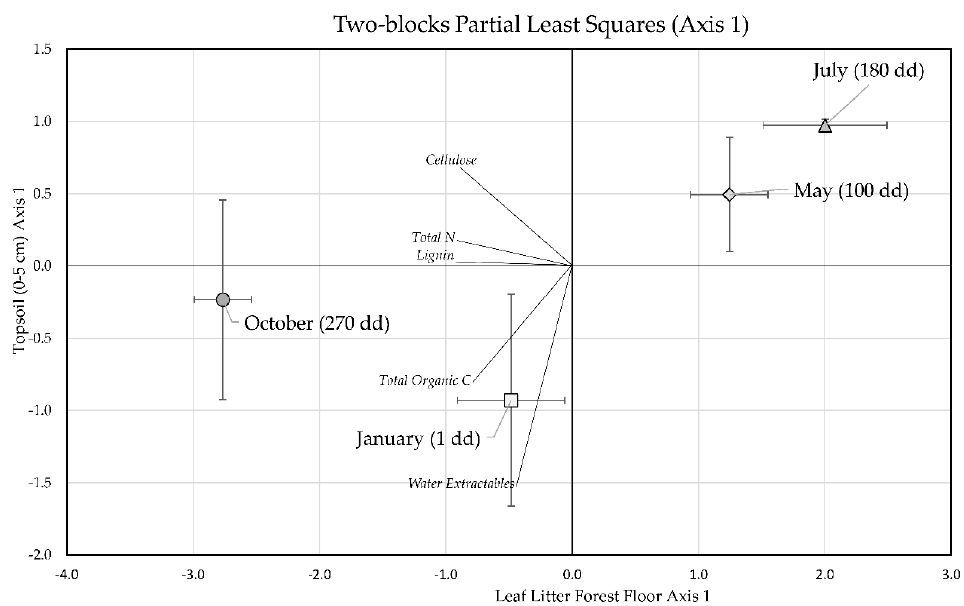
Figure 4. Graphical representation of Axis 1 of the two-block PLS. Variation on the x -axis is forest floor leaf litter and on the y -axis for the topsoil. Values represent the mean score for the replicates ( N = 6) with standard error of the mean. Total phenols and ethanol extractables are not shown in the biplot given their lack of importance. Months and decomposition days (dd) in the litterbag experiment are reported.